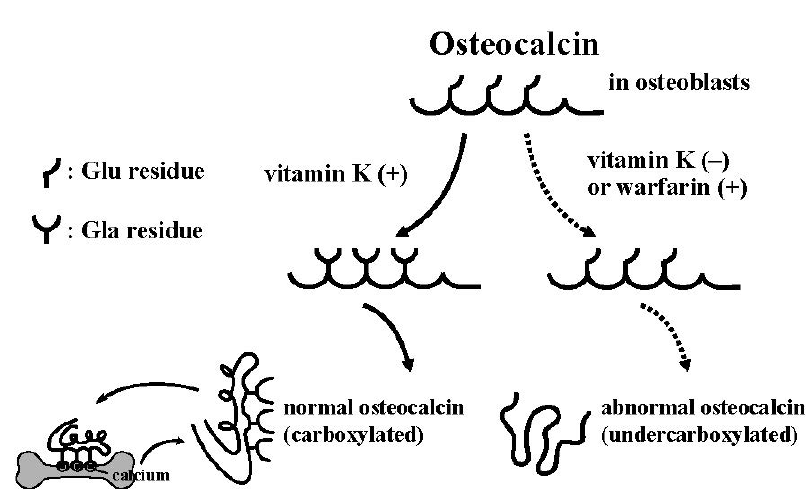
Figure 2. γ -Carboxylation of osteocalcin by vitamin